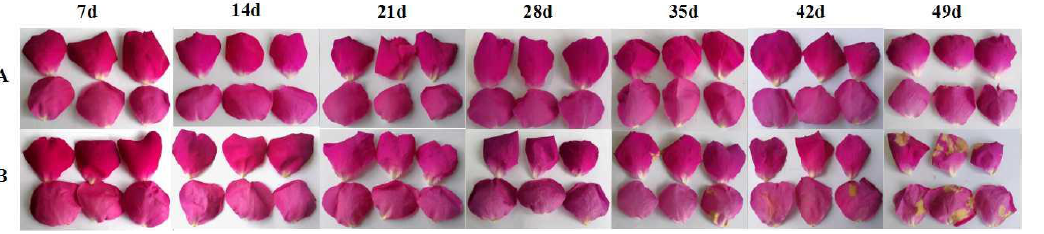
Figure 2. The status of ’Dianhong’ rose petals in different storage periods after 1 − MCP treatment ( A is the 1 − MCP treatment group and B is the control group) ( p < 0.05, n = 3).